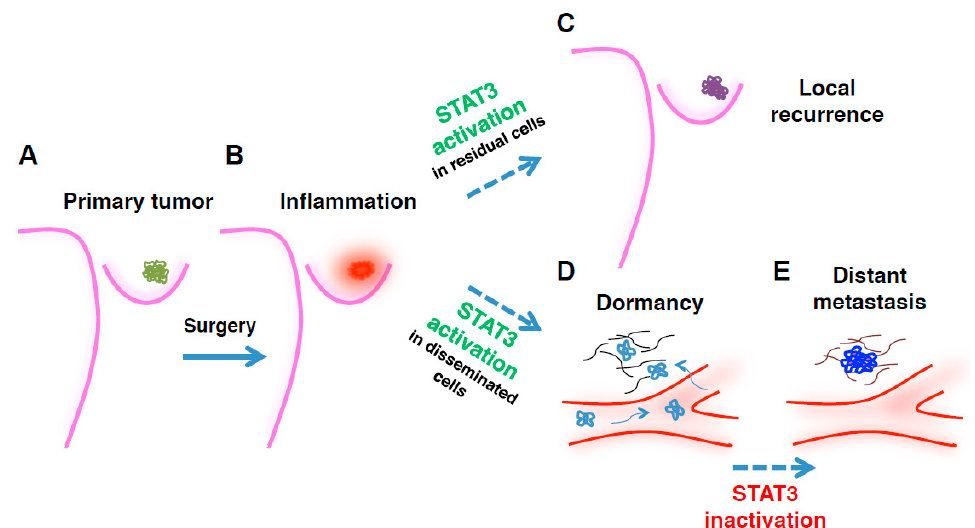
Figure 1. Time- and context-dependent requirement for signal transducer and activator of transcription 3 (STAT3) in breast cancer (BC) epithelial cells during disease progression. Picture depicts the proposed working model for how, where, and when STAT3 (in)activation is required by transformed mammary epithelial cells, to promote growth of primary tumor, locoregional recurrence, and/or distant metastasis. ( A ) Primary breast cancer lesions are often characterized by high levels of STAT3 activation; ( B ) Following surgical removal of the tumor mass, a surgery-induced inflammatory environment sustains, via massive local secretion of inflammatory cytokines and growth factors, the survival and re-growth of residual BC cells, at least in part via STAT3 signaling ( C ). However, in distantly disseminating BC cells, STAT3 activation can contribute to the establishment of a dormant phenotype that supports the metastatic cell survival in hostile and challenging environments ( D ). Under the pressure of cancer evolution, sub-clones carrying mutations inactivating the JAK2/STAT3 pathway emerge, overgrowing the dormant population and giving rise to frank metastases ( E ). The picture does not take into account the very relevant, and possibly contrasting, roles played by STAT3 in non-transformed cells, such as stromal cells, immune cells, and astrocytes.